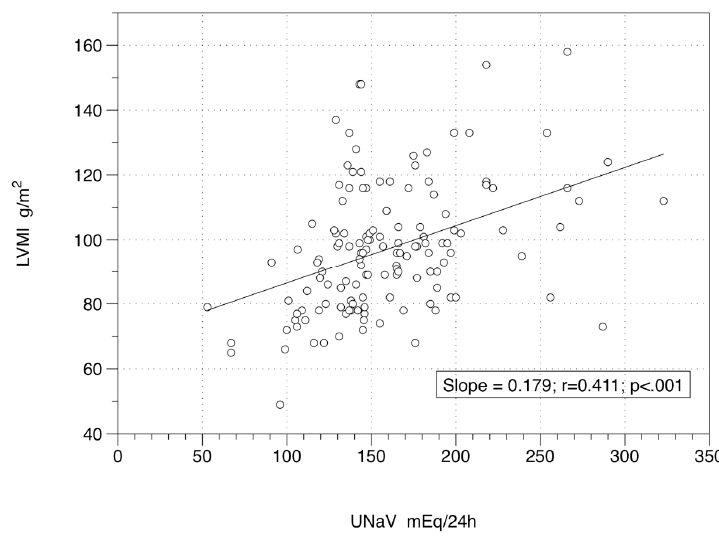
Figure 1. Relationship between left ventricular mass index and 24-h sodium excretion at baseline. Figure 1 Legend: 138 patients under active drug treatment at Time 0, when a low-sodium diet was administered. Equation of the regression line is y = 68.53 + 0.18x. UNaV: 24-h urinary sodium (excretion); LVMI: left ventricular mass index.